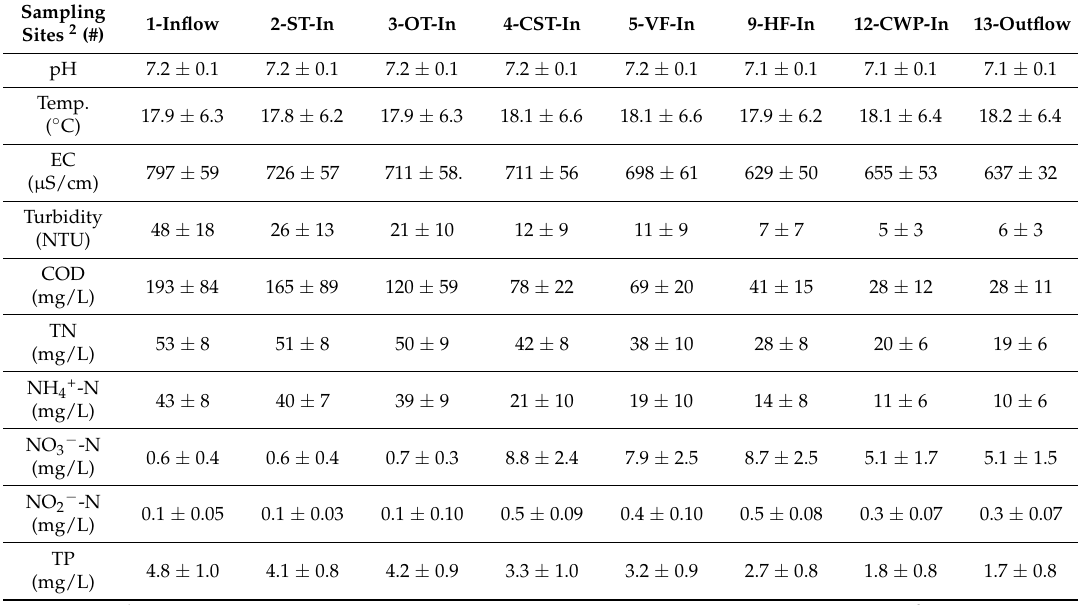
Table 1. The overall distribution of pollutants concentrations along with the treatment stages 1 . Sampling Sites 2